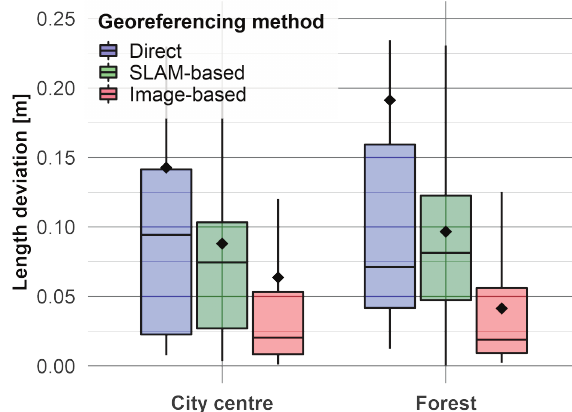
Figure 8. Boxplot with length deviations between measured 3D distances and ground truth representing the relative accuracy. All samples are listed from left to right by test area (“City centre” and “Forest”) and georeferencing method (“Direct” (blue), “SLAM-based” (green) and “Image-based” (red)). The black diamond symbol indicates the mean 3D distance deviation.